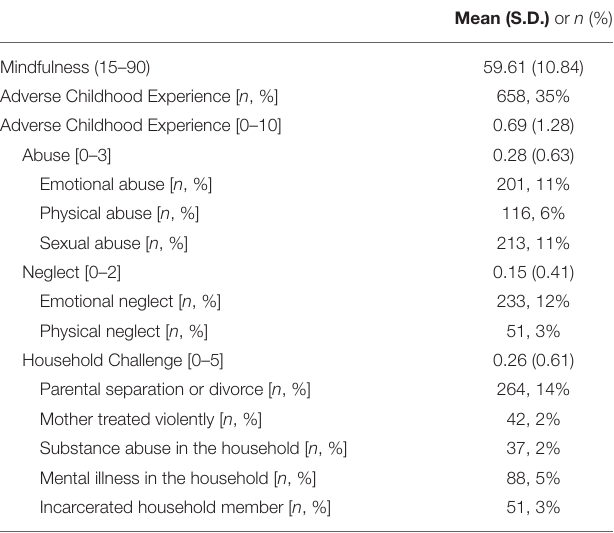
TABLE 1 | Level of mindfulness and adverse childhood